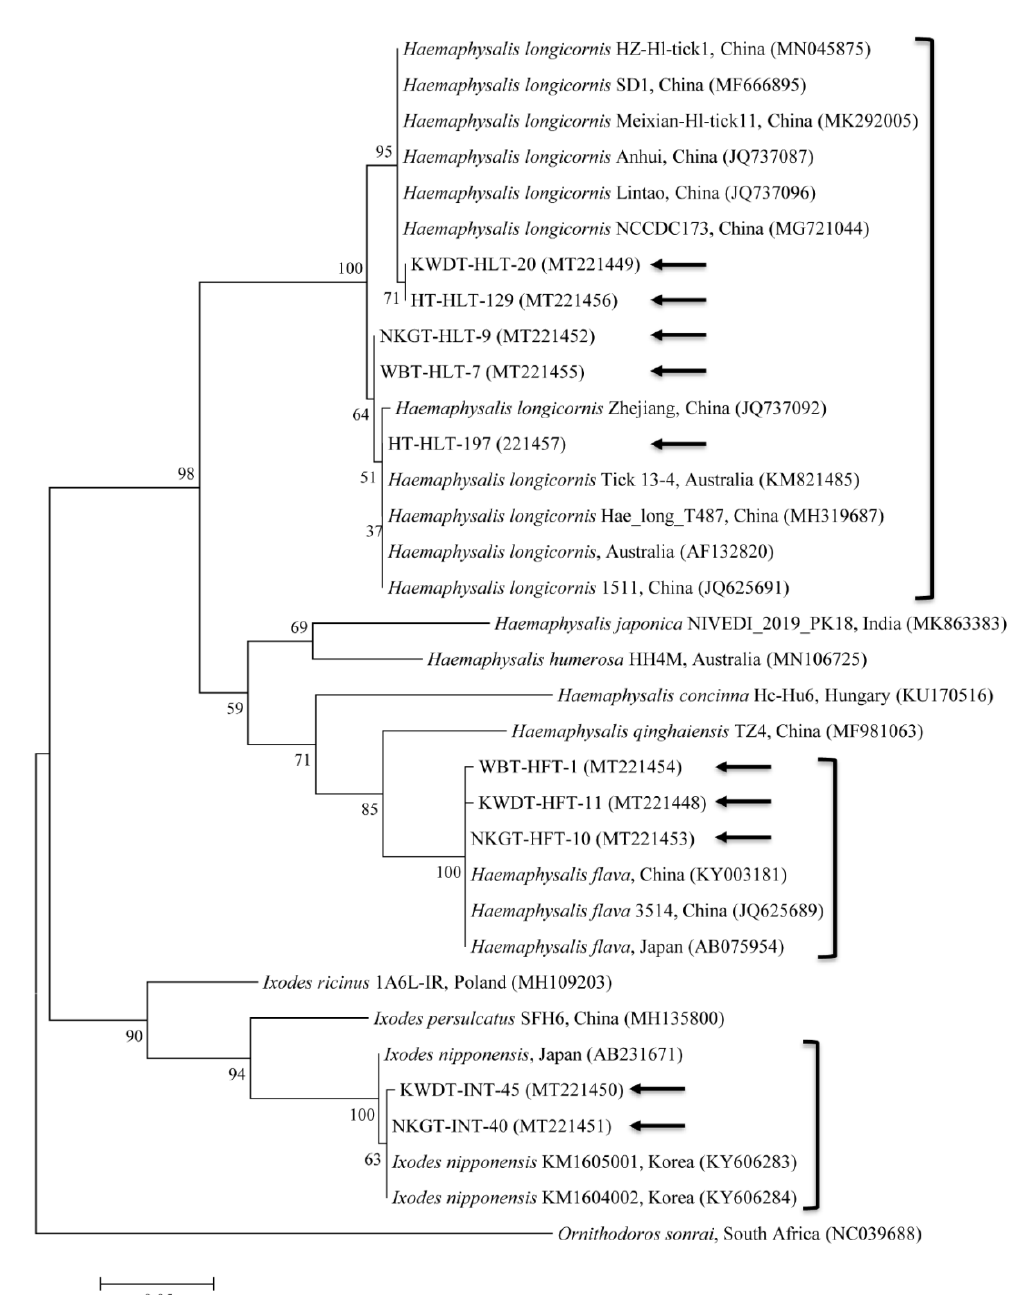
Figure 1. Molecular identification of ticks, collaborated with morphologic identification, according to phylogenetic analysis using the maximum likelihood method with the mitochondrial cytochrome c oxidase subunit I gene. Ornithodoros sonrai was used as the outgroup. Black arrows indicate the sequences analyzed in this study. GenBank accession numbers for other sequences are shown with the sequence name. Branch numbers indicate bootstrap support (1000 replicates). The scale bar indicates the number of substitutions per